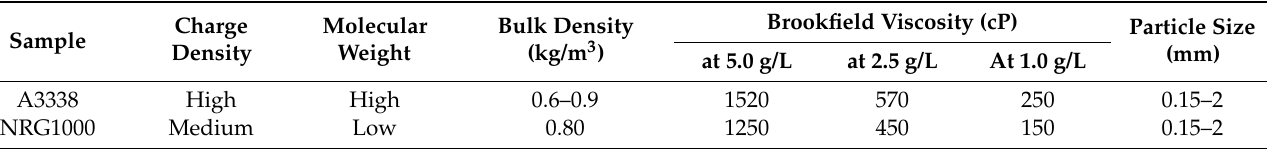
Table 5. Characterization of polymers A3338 and NRG1000.